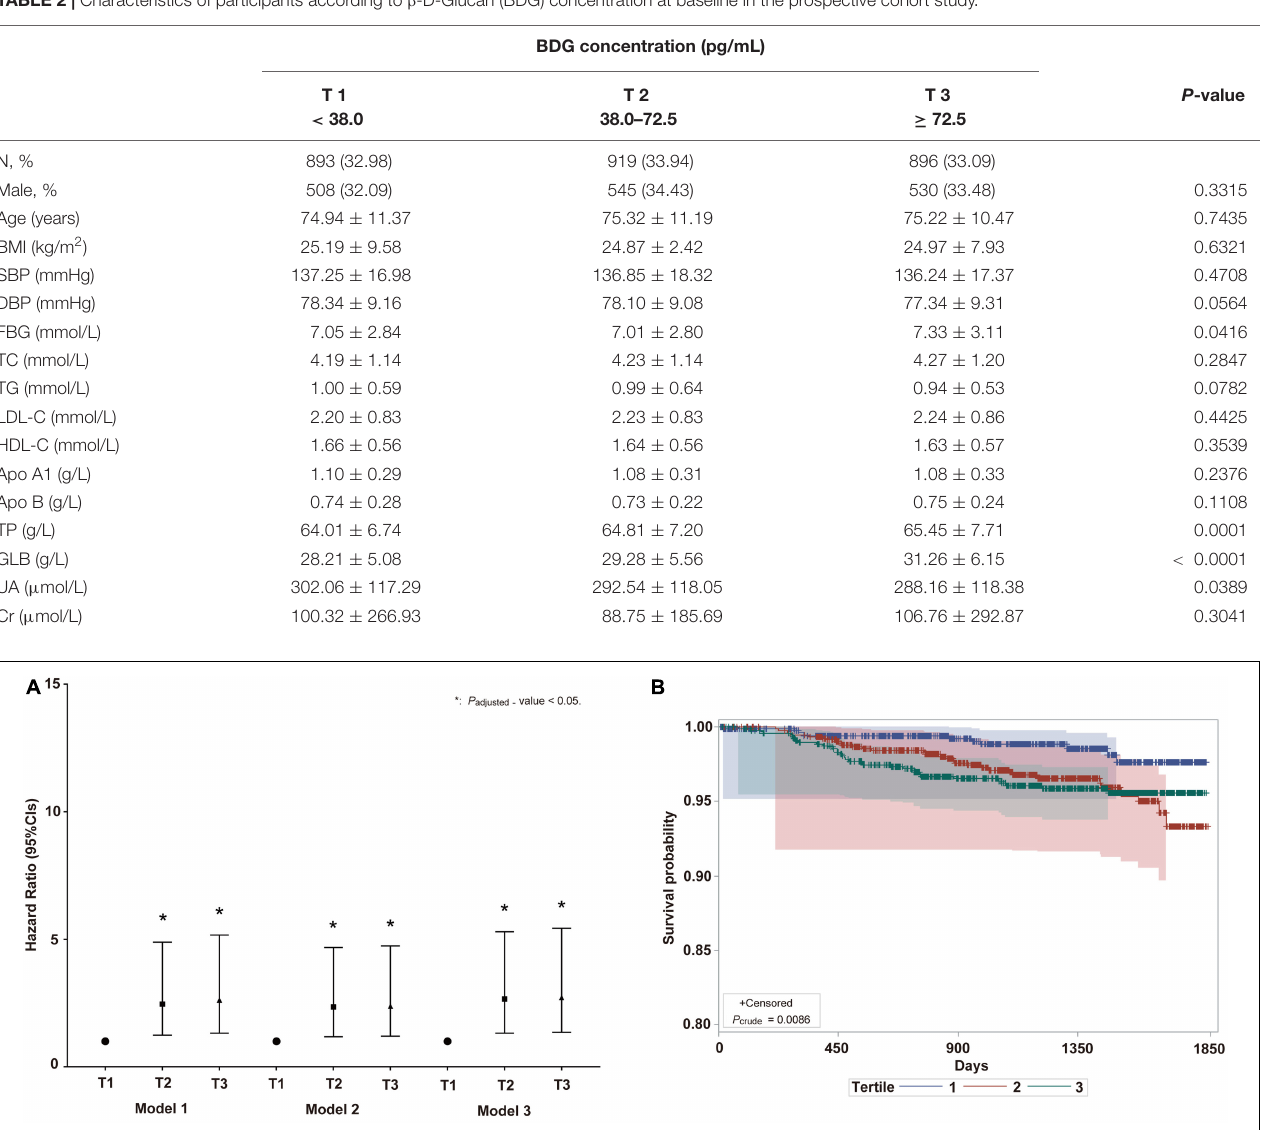
FIGURE 3 | The IFI on HP risk in prospective cohort study. (A) Hazard ratio and 95% CIs of IFI on HP risk in total population. Model 1: adjusted by age and gender; Model 2: adjusted by age, gender, BMI, SBP, DBP, FBG, TC, TG, HDL-C, Apo-B, UA, and Cr; Model 3: adjusted by age, gender, BMI, SBP, DBP, FBG, TC, TG, HDL-C, Apo-B, UA, Cr, LDL-C, Apo-A1, and TP. BMI, body mass index; SBP, Systolic blood pressure; DBP, diastolic blood pressure; FBG, fasting blood glucose; TC, total cholesterol; TG, triglyceride; HDL-C, high-density lipoprotein cholesterol; Apo B, Apolipoprotein B; UA, uric acid; Cr, creatinine; LDL-C, low-density lipoprotein cholesterol; Apo A1, Apolipoprotein A1; TP, total protein; OR, odds ratio. (B) Survival probability curve of HP among BDG concentration analyzed by log-rank regression. CIs, confidence intervals; IFI, invasive fungal infection; HP, hypostatic pneumonia. The meaning of “*” is P -value <